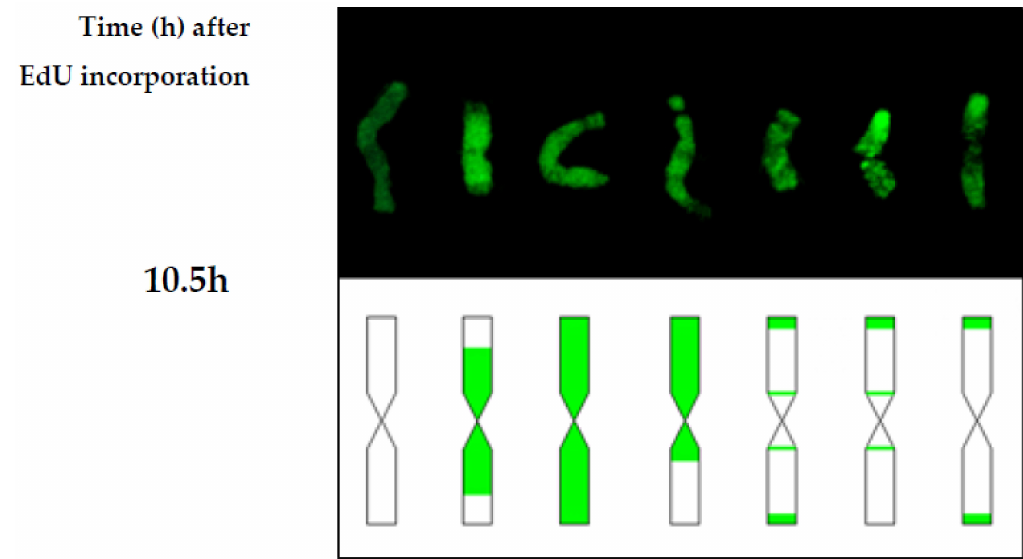
Figure 5. Types of replication patterns in the barley chromosomes in MH-treated roots at 10.5 h after EdU incorporation. Chromosomes with different replication patterns and their corresponding schematic presentation are shown. Only one morphological type of chromosome is presented in order to simplify the scheme.